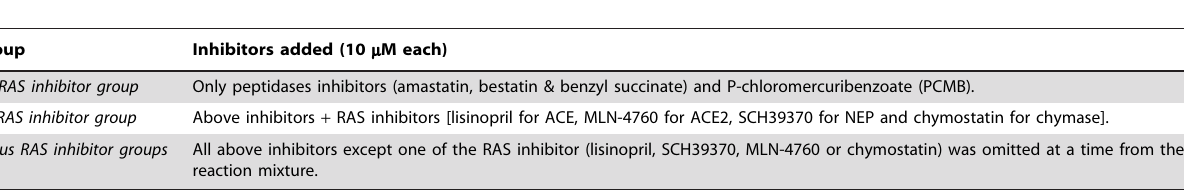
Table 2. Outline of enzyme inhibitors employed in the experiments.